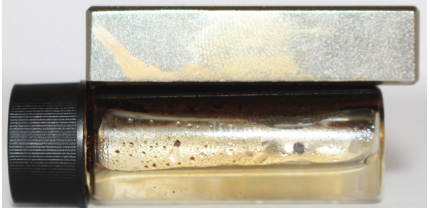
Figure 11: A fully phase-separated system under the influence of an external magnetic